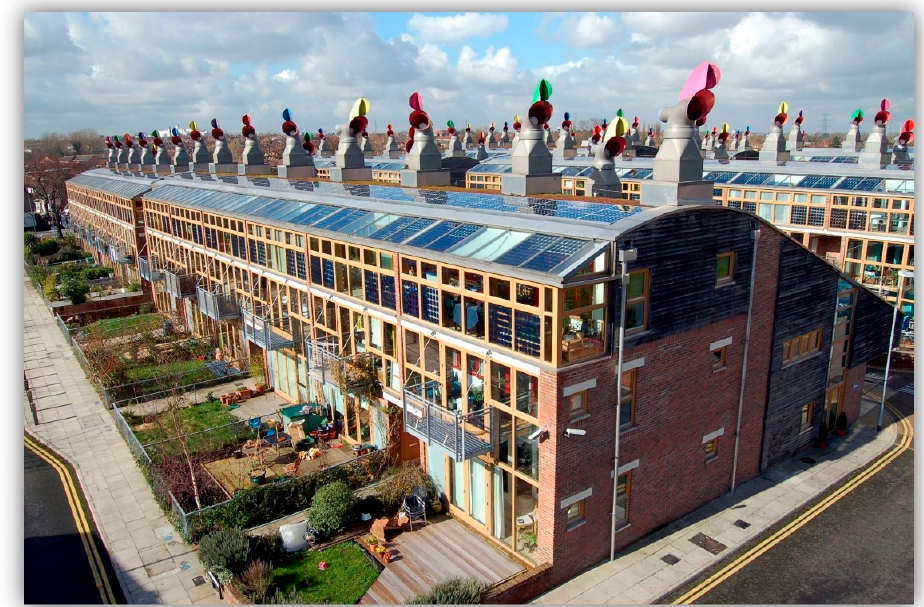
Figure 1. BedZED project in Hackbridge, London borough of Sutton, with solar panels, wind cowls, and green roofs. Source: Image credits Tom Chance https://www.flickr.com/photos/tomchance/10 08213420/ CC BY 2.0, accessed on 22 July